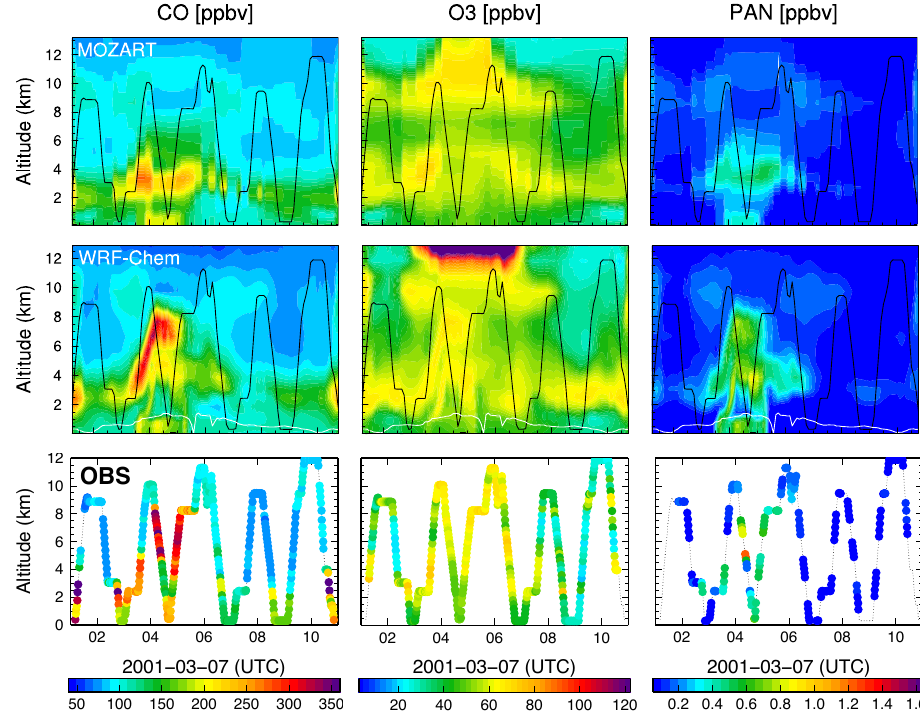
Figure 6. Observed (1-min merged) and predicted vertical profiles of trace gases along the DC-8 flight track on 7 March during the TRACE-P campaign. The black line denotes the flight path also shown in Figure 4 with corresponding UTC labels. White lines indicate boundary layer heights.